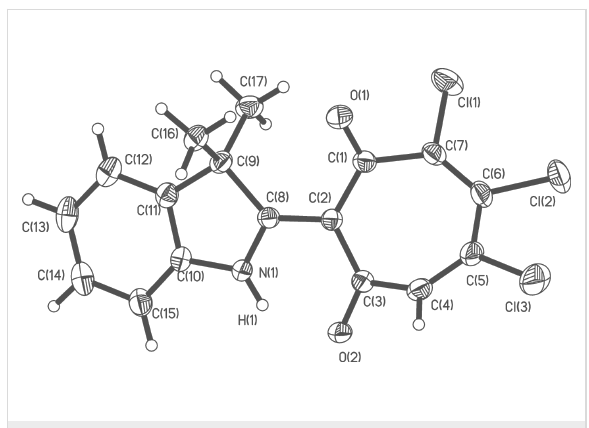
Figure 1: Molecular structure of 2-(3,3-dimethylindolyl)-5,6,7-trichloro- 1,3-tropolone 5g . Thermal ellipsoids are drawn on the 30% probability level. Selected bond lengths (Å): O(1)–C(1) 1.210(3), O(2)–C(3) 1.248(3), N(1)–C(8) 1.333(3), C(1)–C(2) 1.468(4), C(1)–C(7) 1.723(3),